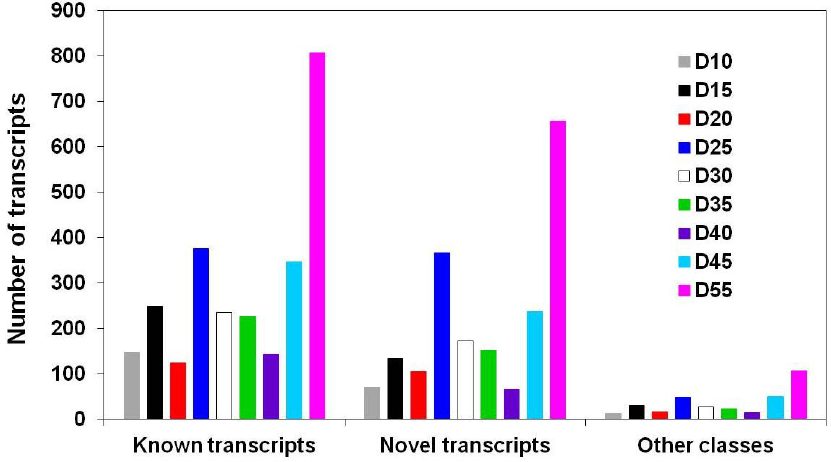
Figure 2. Distribution of known, novel, and other class isoforms in developing soybean embryos. Results are shown for 2,942 isoforms encoded by genes expressing between two and six isoforms showing changes in their transcript levels during soybean embryo development (day 10 (D10) (cid:177) day 55 (D55)). Other Cuffcompare classes represent o